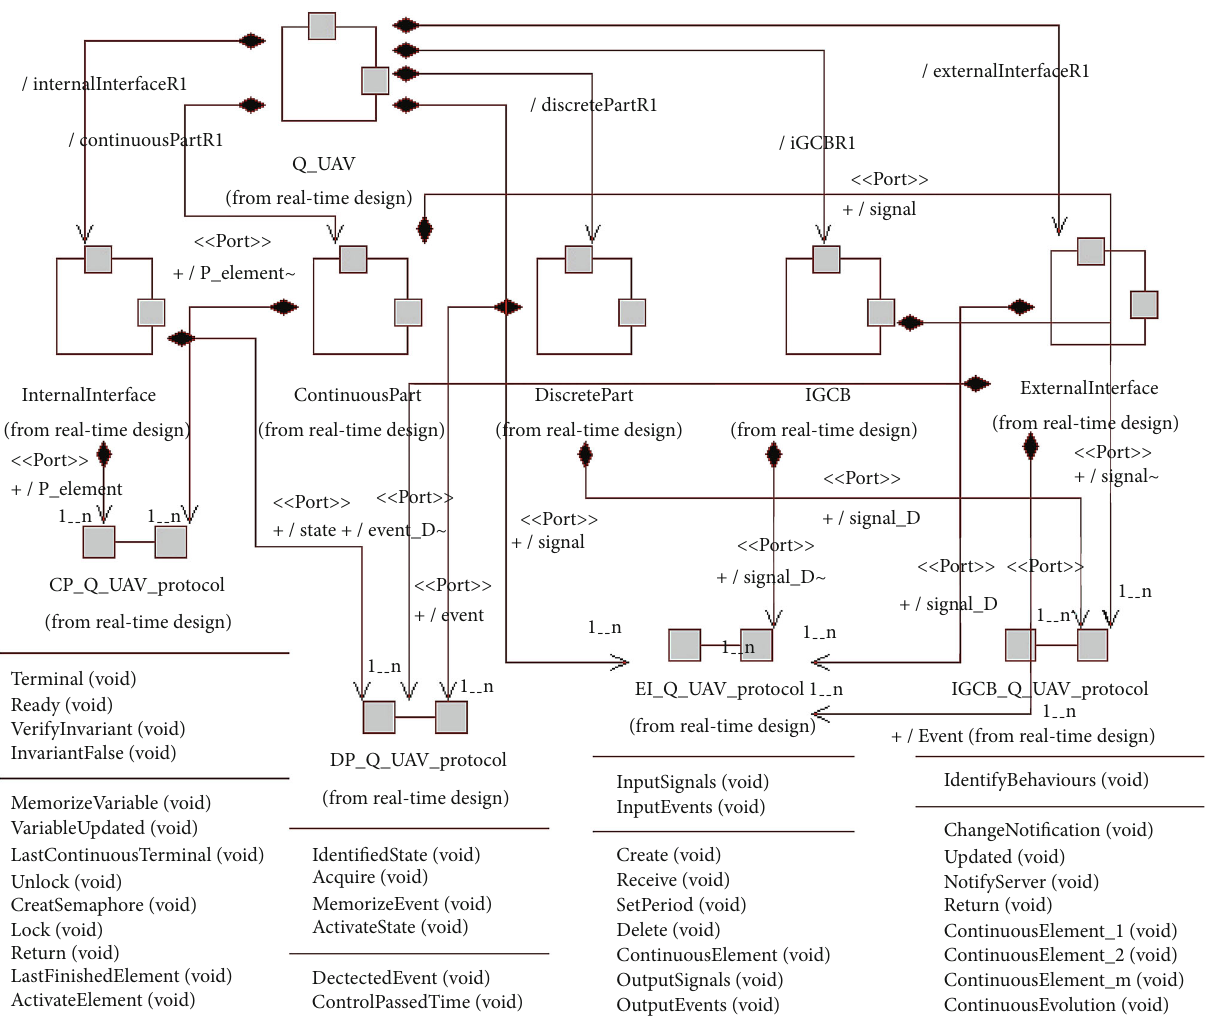
Figure 7: Class diagram of the real-time capsule pattern for the Q-UAV